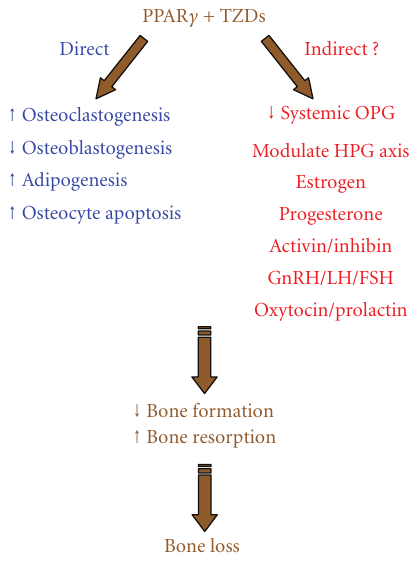
Figure 1: Potential mechanisms for TZD-induced bone loss. In vivo studies in both clinical trials and using animal models demonstrate that TZDs, a class of diabetic drugs that functions as PPAR γ agonists, cause bone loss and increased fracture risk, especially in postmenopausal women, by simultaneously inhibiting bone formation and stimulating bone resorption. In addition to the well- documented direct e ff ects of TZDs on bone cell di ff erentiation and function, emerging evidence indicate that TZD may also exert its detrimental skeletal e ff ects via several potential indirect e ff ects, which provokes further investigation in future preclinical and clinical